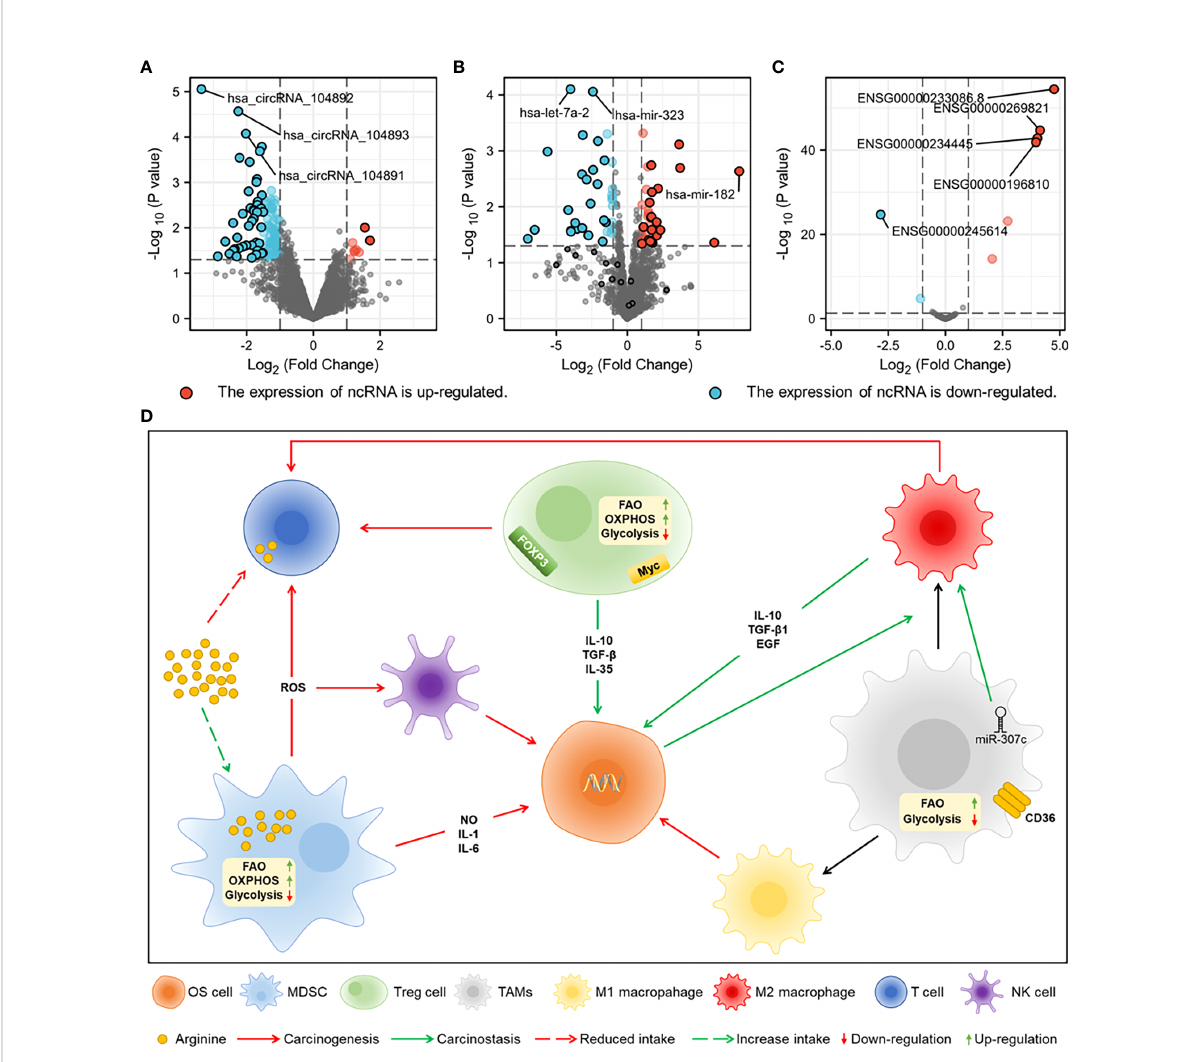
FIGURE 1 The sequencing results of ncRNAs from normal tissues and OS tissues of human are downloaded from GEO datasets of National Center for Biotechnology Information (NCBI) for difference analysis. (A) Differential expression analysis of miRNAs (GSE70367). (B) Differential expression analysis of lncRNAs (GES156344). (C) Differential expression analysis of circRNAs (GSE96964). (D) Metabolic characteristics of MDSC, TAMs and Treg cells in TME and crosstalk of them with NK cells, T cells and OS cells. MDSC promotes the growth of OS cells by secreting in fl ammatory factors, damages T cells and NK cells by secreting ROS, and competitively consumes arginine with T cells. Treg cells inhibit T cell function by expressing FOXP3 and myc. CD36 receptor and miR-307c in TAMs promote M2 polarization, and FAO is the main energy